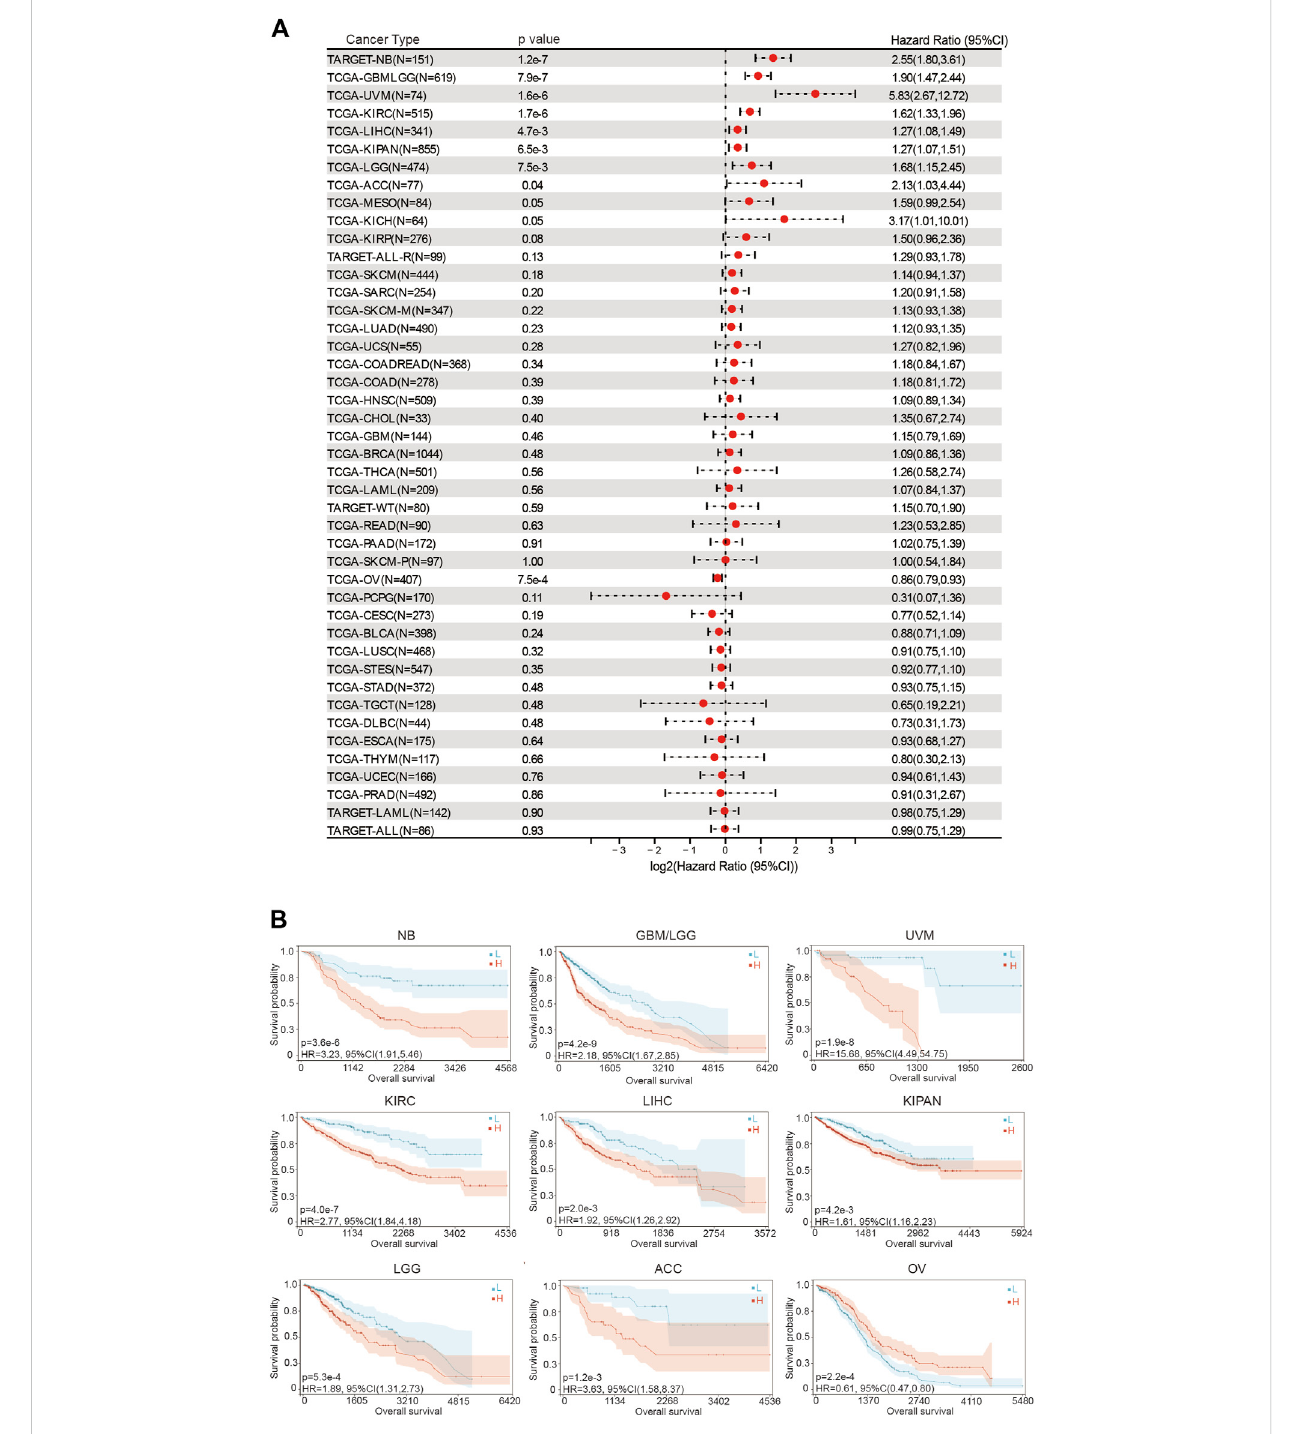
Association of BOLA2B with poor overall survival prognosis in cancers. (A) Hazard ratio of BOLA2B expression in different cancers from the TCGA dataset. (B) RepresentativeimagesofBOLA2Bin fl uenceonprognosisofNB,GBMLGG,UVM,KIRC,LIHC,KIPAN,LGG,ACC,andOV.Thex-axisrepresents the number of